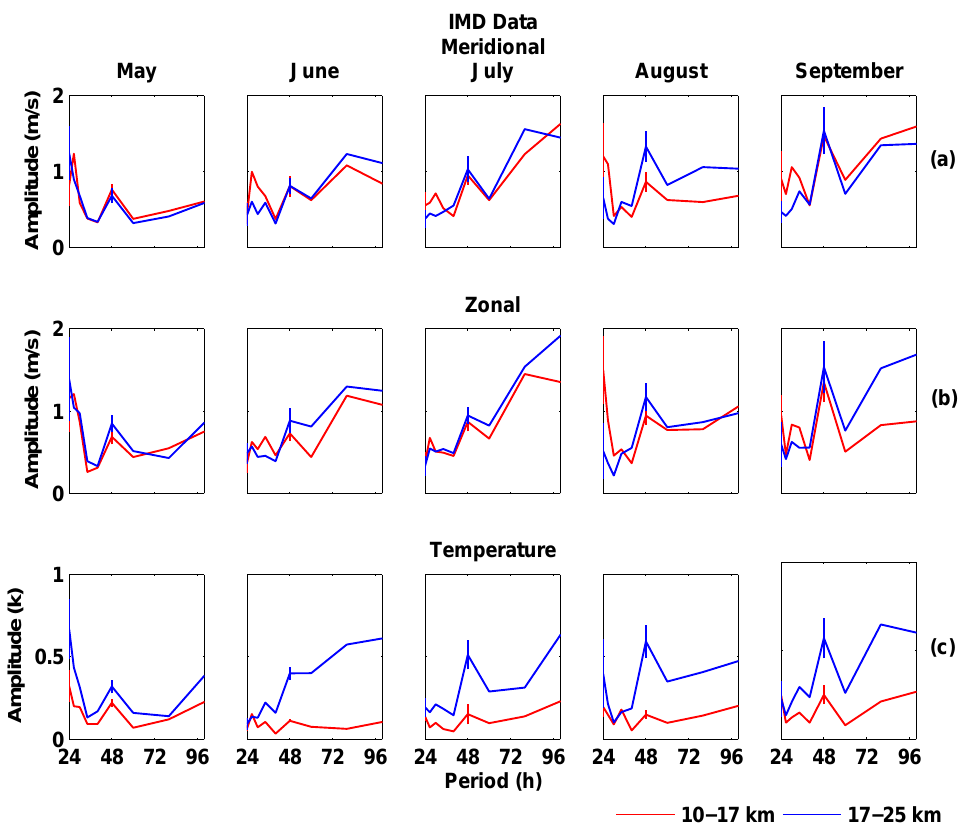
Fig. 3. Monthly FFT spectra of meridional (a) , zonal (b) wind and temperature (c) fluctuations of IMD datasets for different height blocks. Vertical bars showing 95% confidence level are plotted on 2-day wave